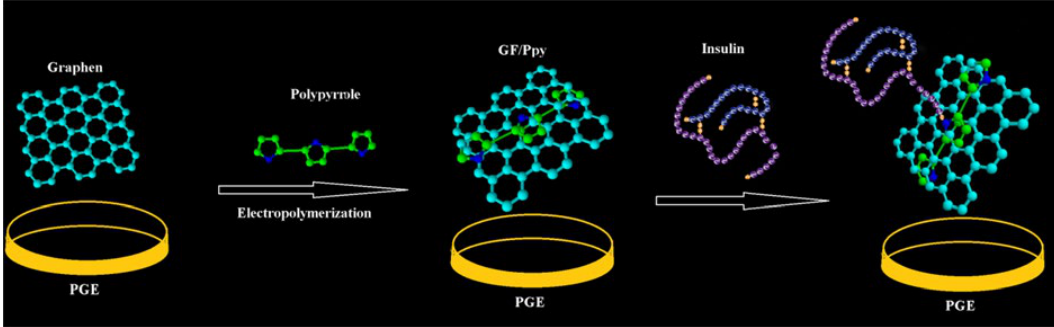
Fig. 1 . Schematic illustration of polypyrrole/graphene naocomposite (PPy-GF) modified pencil graphite electrode (PGE) for insulin detection